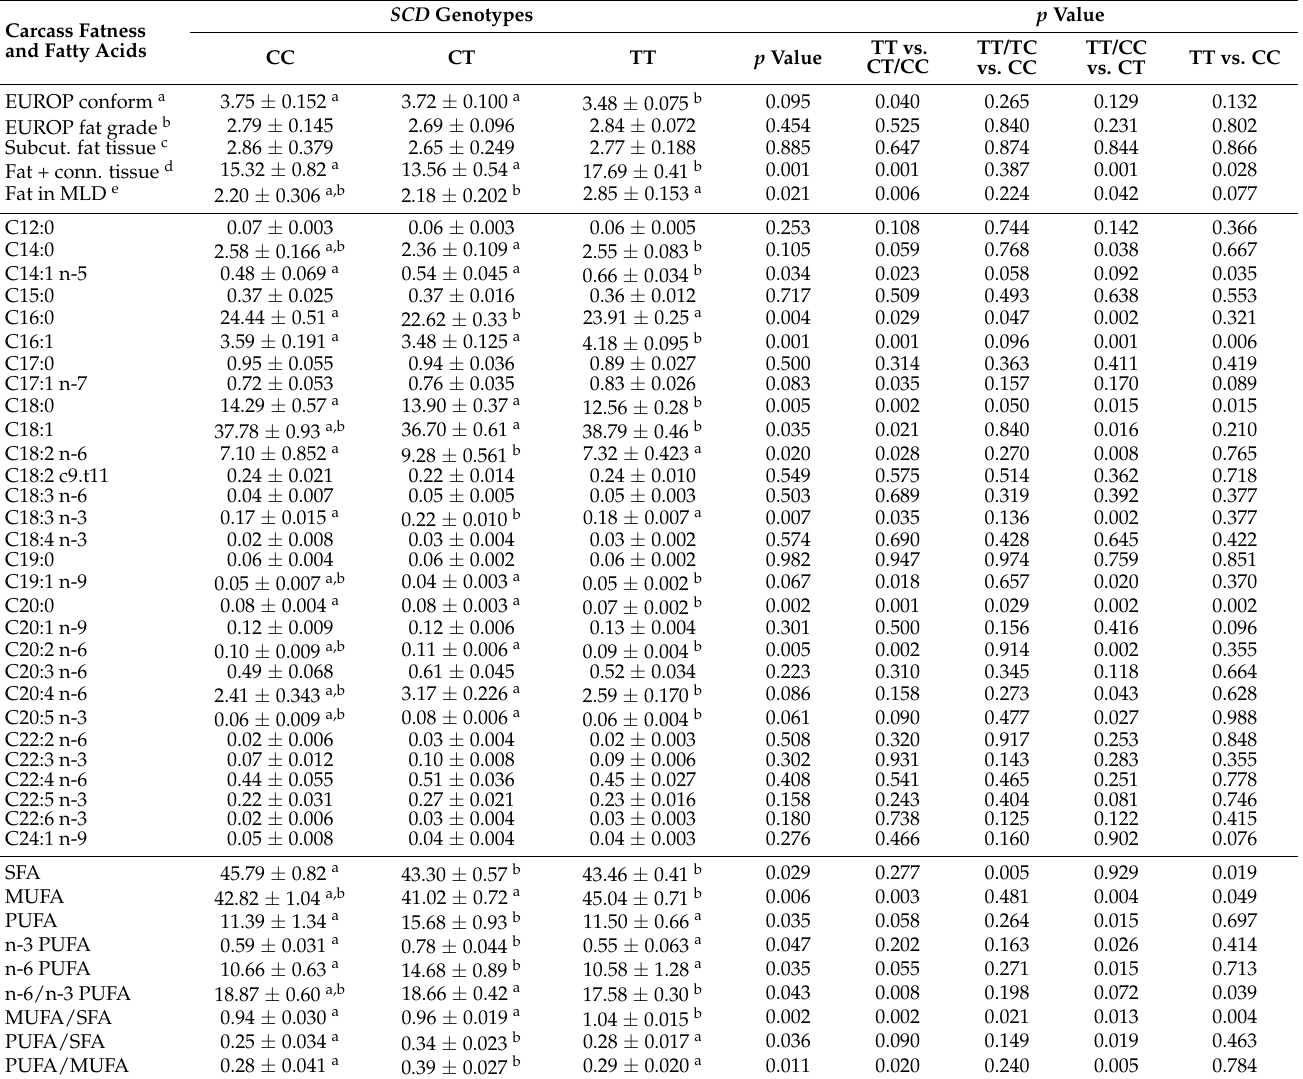
Table 4. Carcass fatness and fatty acid content in MLD , their sums and ratio by SCD genotypes (LS Mean ± SE and p